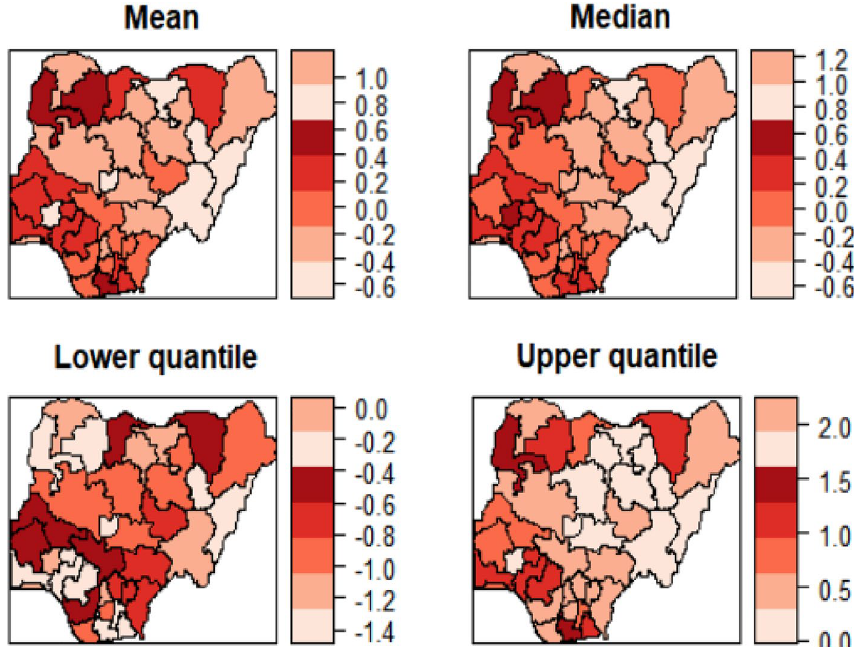
Figure 3. Nigeria state-level estimated posterior mean of the structured spatial effect maps: (a) Mean, (b) Median, (c) 25% quantile and 97.5% quantile for